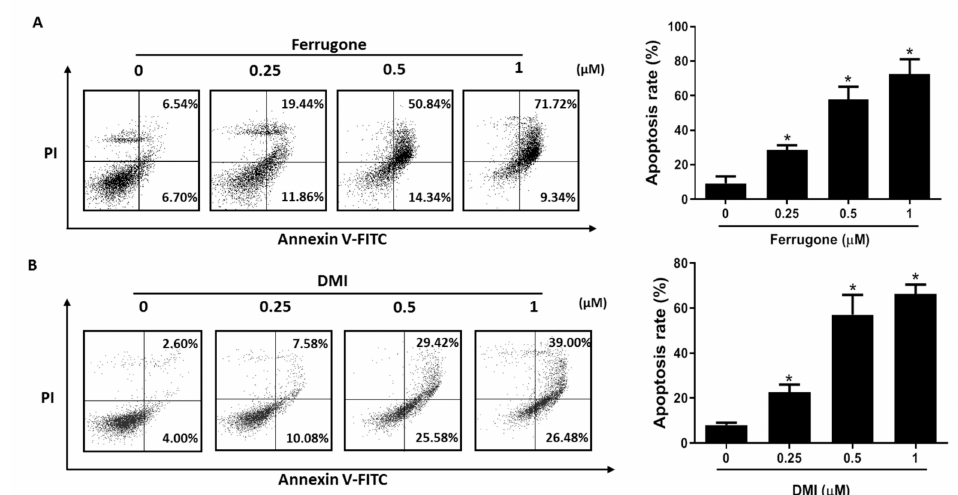
Figure 2. E ff ect of ferrugone and DMI on apoptotic cell death in human ovarian cancer cells. A2780 cells were treated with ferrugone ( A ) and DMI ( B ) (0.25, 0.5, and 1 µ M) for 48 h and co-stained with PI and Annexin V-FITC (fluorescein isothiocyanate). The translocation of phosphatidyl serine was detected by flow cytometry. The graph indicates the percentages of annexin V-positive apoptotic cells in the right quadrants of flow cytometry graphs. The data are representative of three independent experiments. Data were analyzed using one-way ANOVA followed by Dunnett’s multiple comparison test. * p < 0.05 as compared with untreated